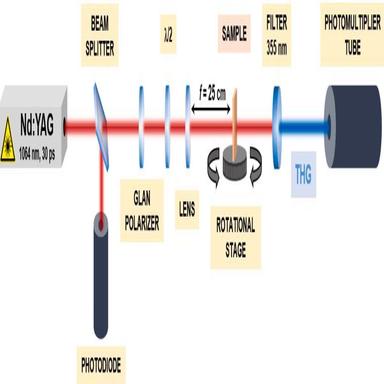
THG experimental set-up based on maker fringe technique.